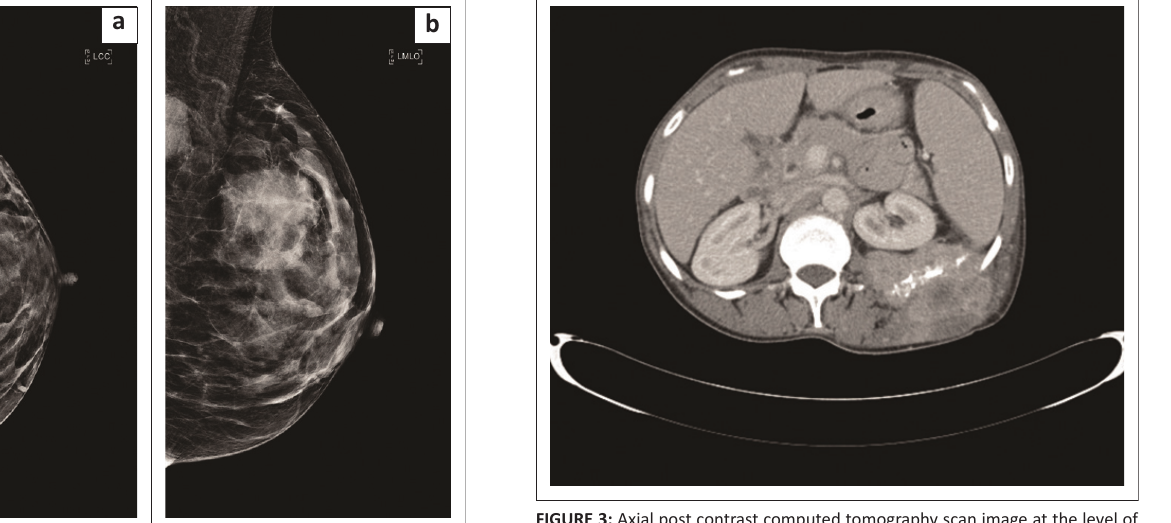
FIGURE 3: Axial post contrast computed tomography scan image at the level of the 12th rib demonstrating the destruction of the left rib with surrounding soft tissue mass. FIGURE 1: (a) Craniocaudal and (b) mediolateral oblique mammogram views of